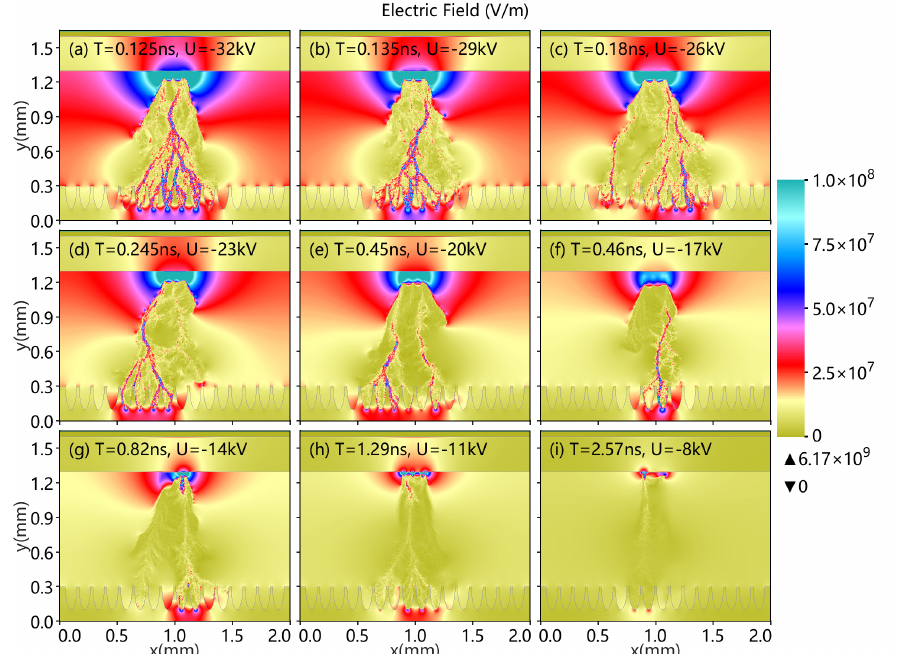
Figure 7. Electric field distributions (Vm − 1 ) of different voltages for the same conditions as in Figure